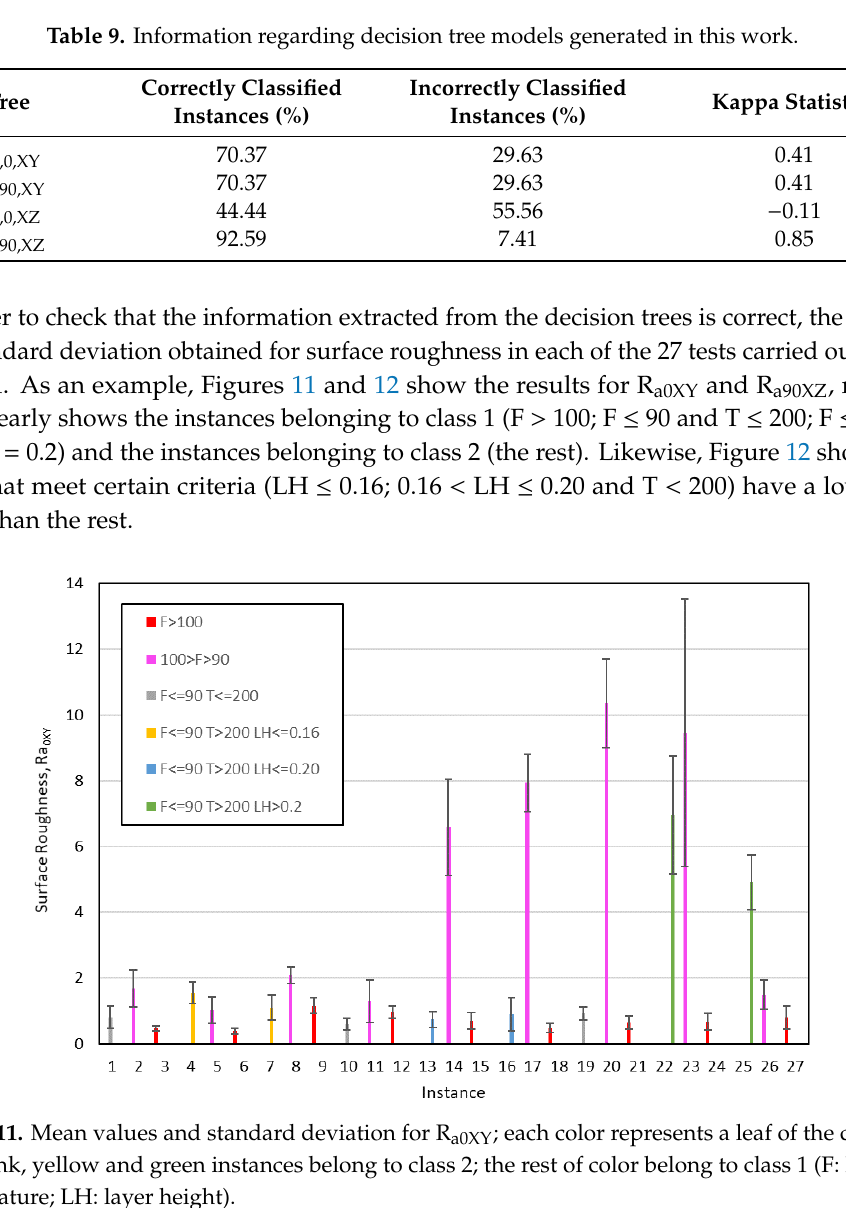
Figure 10. Decision tree for surface roughness measured in the direction perpendicular to the extrusion path on printed specimens in the XZ orientation (R a,90,XZ ). Table 9. Information regarding decision tree models generated in this work.